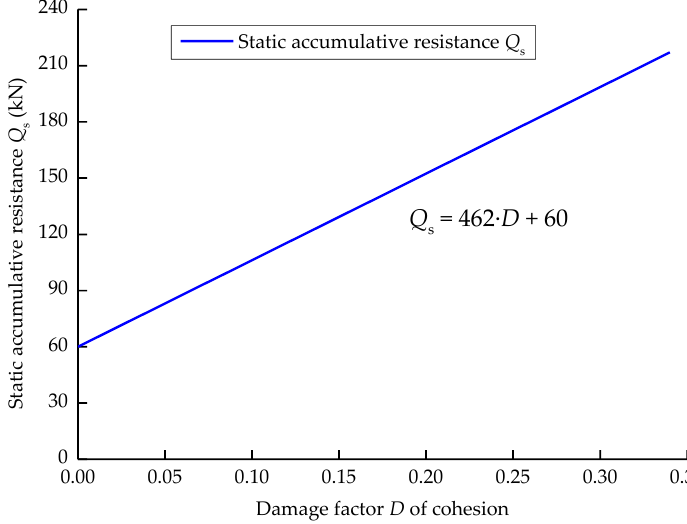
Figure 12. Relationship between static accumulative resistance Q s and damage factor D of cohesion.